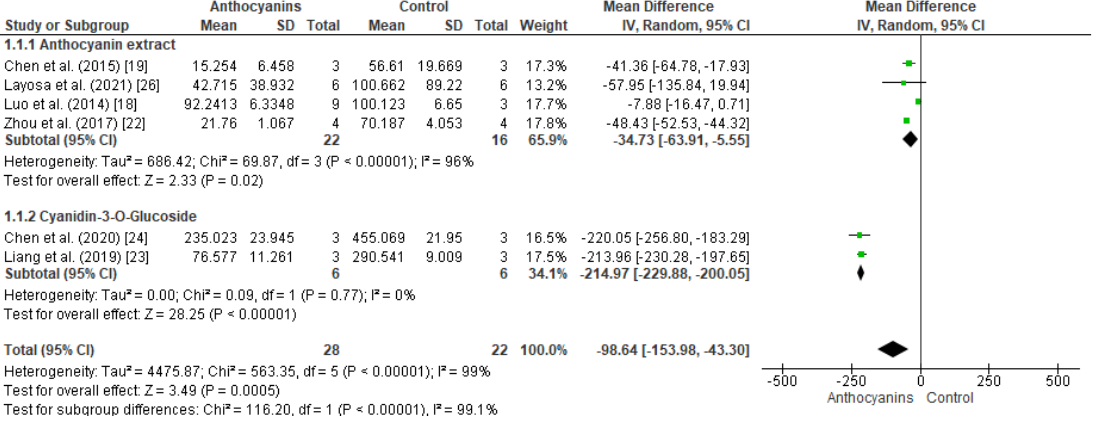
Figure 3. Forest plot of the meta-analysis comparing the anthocyanin-treated TNBC cell line versus the untreated controls in invasion. The analysis was performed in subgroups, with four studies conducted with the anthocyanin-enriched extract and two studies evaluating isolated anthocyanin (cyanidin-3-O-glucoside). IV: inverse variance based on the mean difference; CI: confidence interval. The green box in the middle of each horizontal line represents the point estimate of the effect for each study (the larger the size of the green box, the greater the weight of the study). The black diamond represents the effect estimate of all meta-analysis studies. The position of the diamond indicates which group was significant in modulating the parameter (e.g., if the diamond is on the left side, it means that the anthocyanin group modulated the parameter. However, if the diamond touches the central vertical line, it means that there is no difference between control and anthocyanin groups) [18,19,22–24,26].